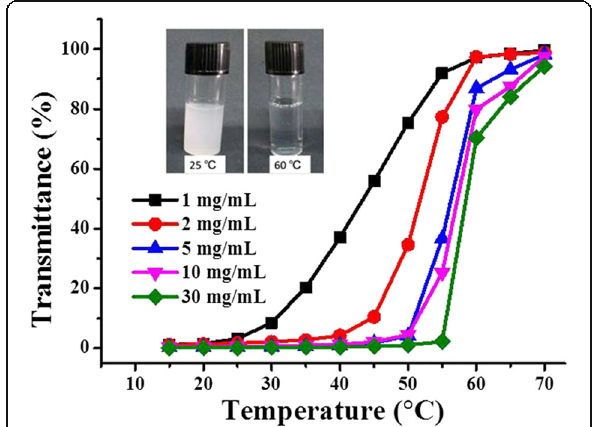
Fig. 5 Transmittance of P(OEGDA-MAA) in ethanol with different concentration. The insets are the optical images of the hydrogels in ethanol (1 mg/mL) at 25 and 60 °C,